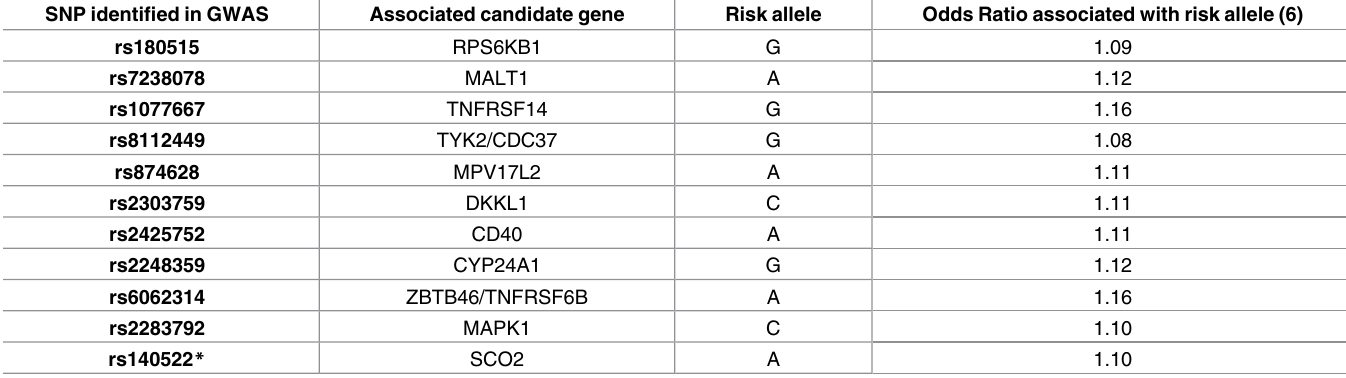
Gaussian for all groups. Details regarding the risk scores are given in Table 4. There was a signifi- cant difference in the risk score between people with MS and healthy controls (p < 0.0005) (Table 4 and Fig 1A). A ROC curvecomparing people with MS with healthy controls generated an area under the curve(AUC) of 0.77 (95% CI 0.70–0.84) (Table 4 and Fig 2A). The contribution from all MS risk alleles was then used to derive the MS risk score (Table 3). There was a significant difference in the risk score between people with MS and healthy controls (p < 0.0005) (Table 3 and Fig 1B). A ROC curve comparing people with MS with healthy controls generated an improved AUC of 0.80 (95%CI 0.74–0.87) (Table 4 and Fig 2B). People with MS had significantly higher deseasonalisedserum 25-OHvD than unaffected siblings and healthy controls; the patients with MS were taking vitamin D supplementation at higher rates than either their siblings or healthy controls (data not shown). The risk scores were therefore calculated without the contribution from 25-OHvD. Under these conditions, when the genetic contribution from HLA-DRB1 (cid:3) 1501 only was included, the AUC was 0.80 (95% CI 0.73–0.87), and when all genetic information was included the AUC increased to 0.82 (95% CI 0.75–0.88) (Table 4 and Fig 2C and 2D).